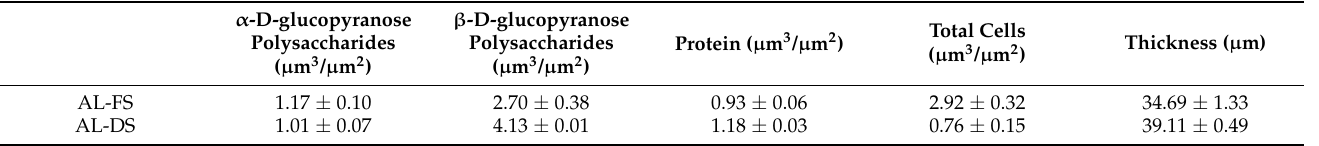
Table 5. Biovolume of the foulants on membrane surfaces in both AL-FS and AL-DS modes after the PRO-MBR operation a